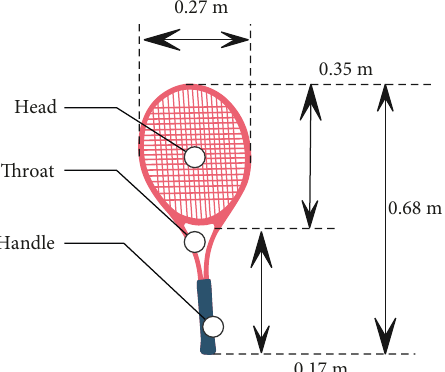
Figure 1: The finite element model of a tennis